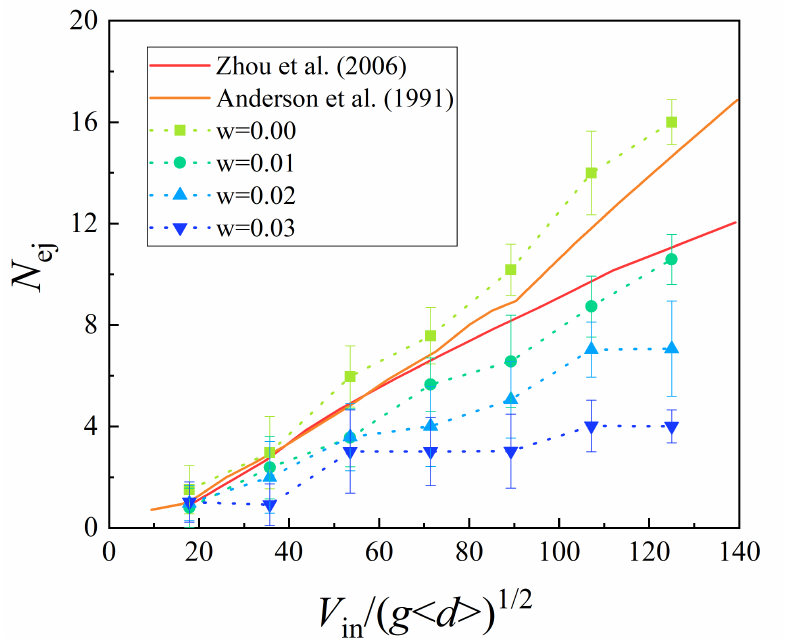
Figure 10. The ejected number of incident grains in sand-bed collision under different surface moisture